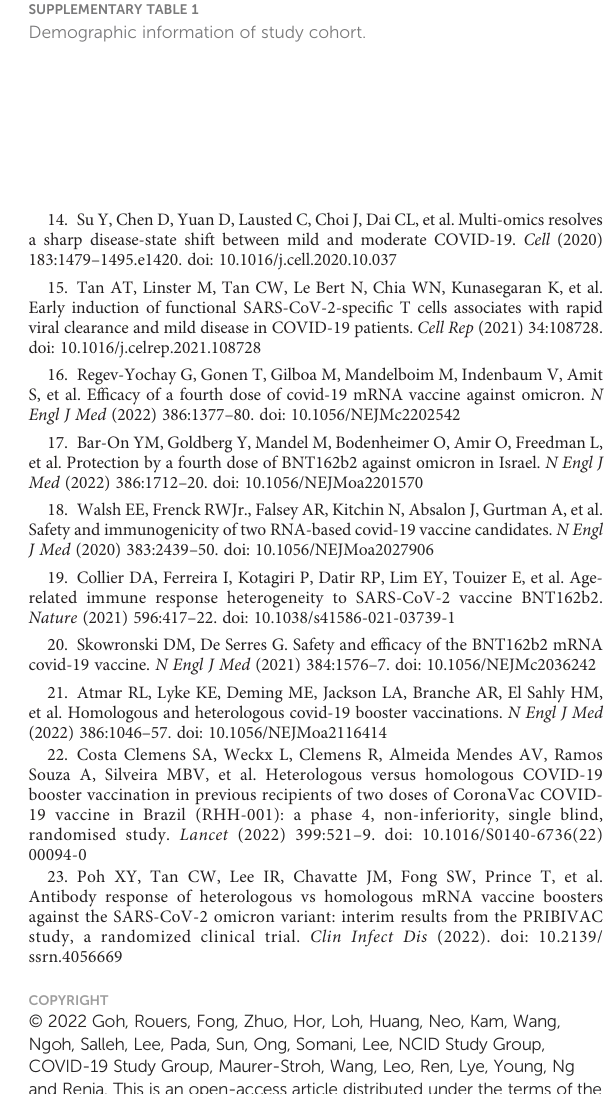
SUPPLEMENTARY FIGURE 3 Antibody response against WT and variant Spike at the four time-points examined. Plasma samples (N=36) were screened for binding against full- length wildtype (WT) and variant Spike in elderly at two months (T1) and fi ve months (T2) following primary vaccination, and one month (T3) and four months (T4) following a third dose (administered 189-270 days post fi rst-dose). SUPPLEMENTARY FIGURE 4 Correlation analysis between humoral and cellular responses. Difference in WT spike antibody response, T4 -T3, were analyzed for correlation with either difference in RBD-speci fi c memory B cell response or Spike-